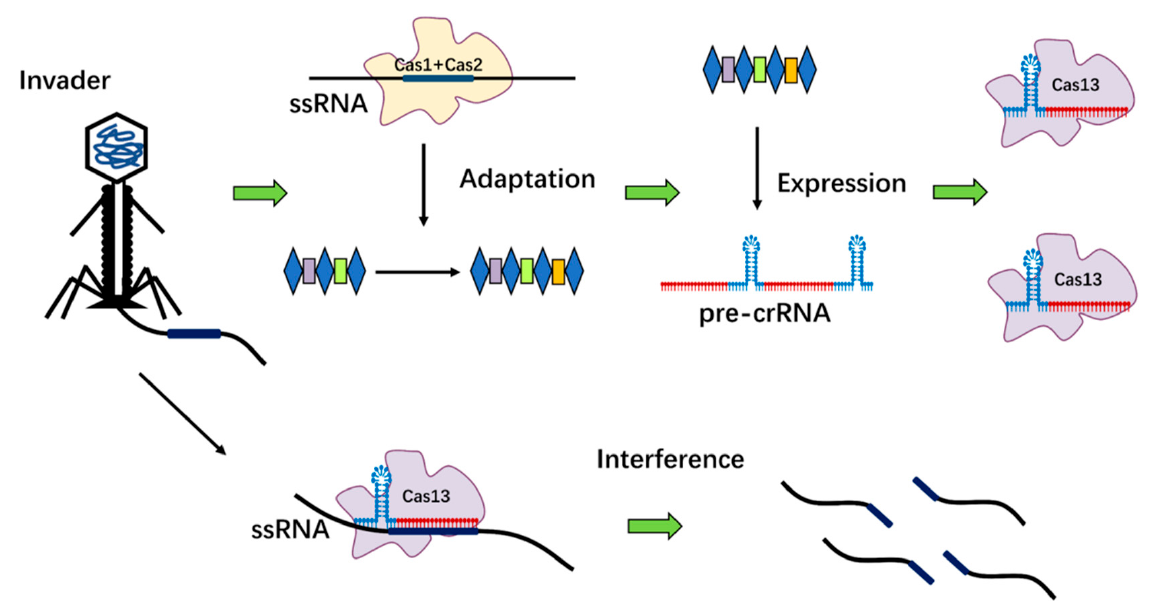
Figure 1. Mechanism of immunity against virus invaders through CRISPR-Cas systems. The molecu- lar defense process of the CRISPR-Cas system includes three phases: adaptation, maturation, and interference. Adaptation: the host organism captures the nucleotide fragments from invaders and integrates them into the CRISPR array; Maturation: CRISPR array is transcribed into precursor crRNA (pre-crRNA) and further processed into mature crRNA; Interference: crRNA binds to the effector Cas protein to form a complex, and the target invader genome (DNA/RNA) is identified and bound with the help of crRNA, which eventually leads to the degradation of the invader genome (DNA/RNA).